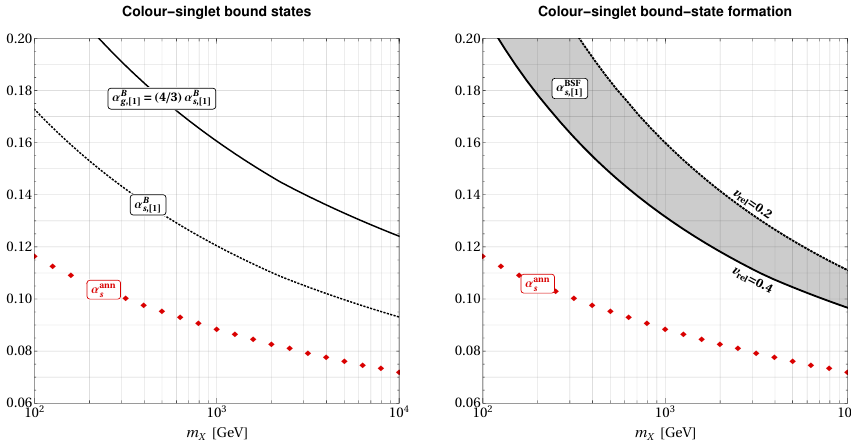
and the corresponding (cid:11) B , that determine the s; [ 1 ] g; [ 1 ] . The emitted gluon carries away s; [ 1 ] s; [ 1 ]